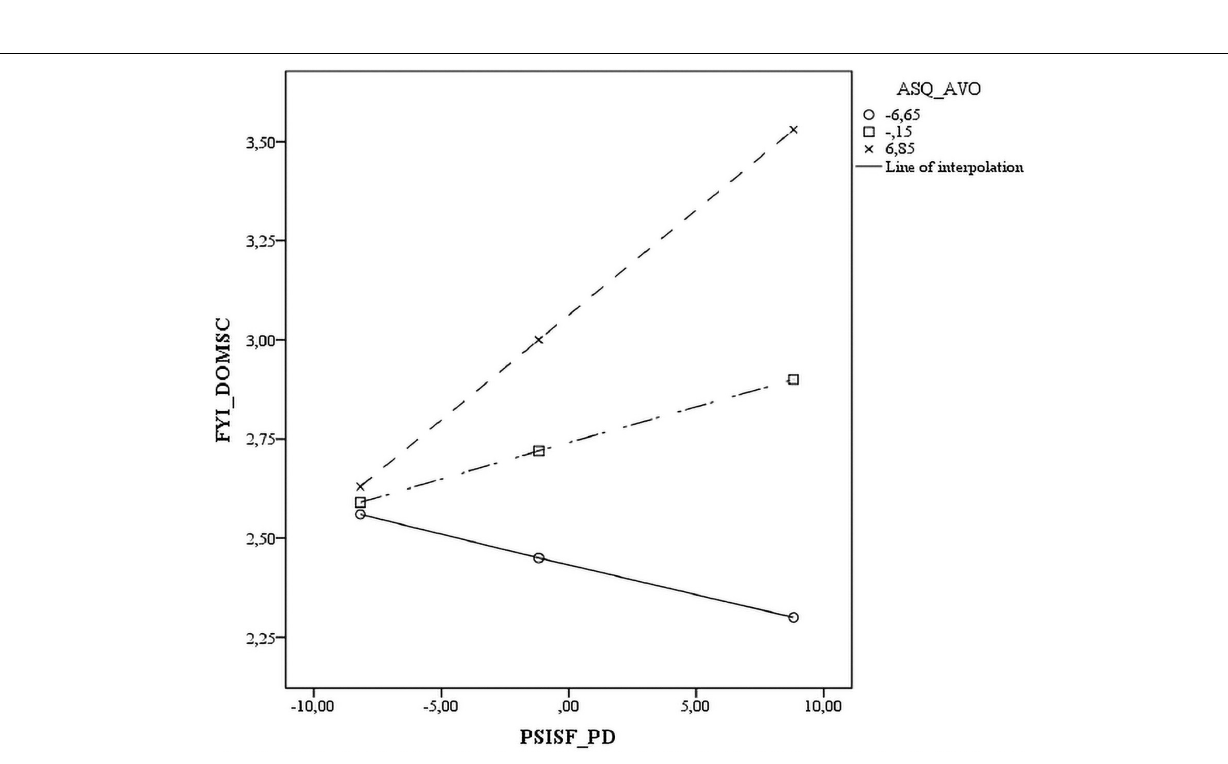
Frontiers in Psychology |